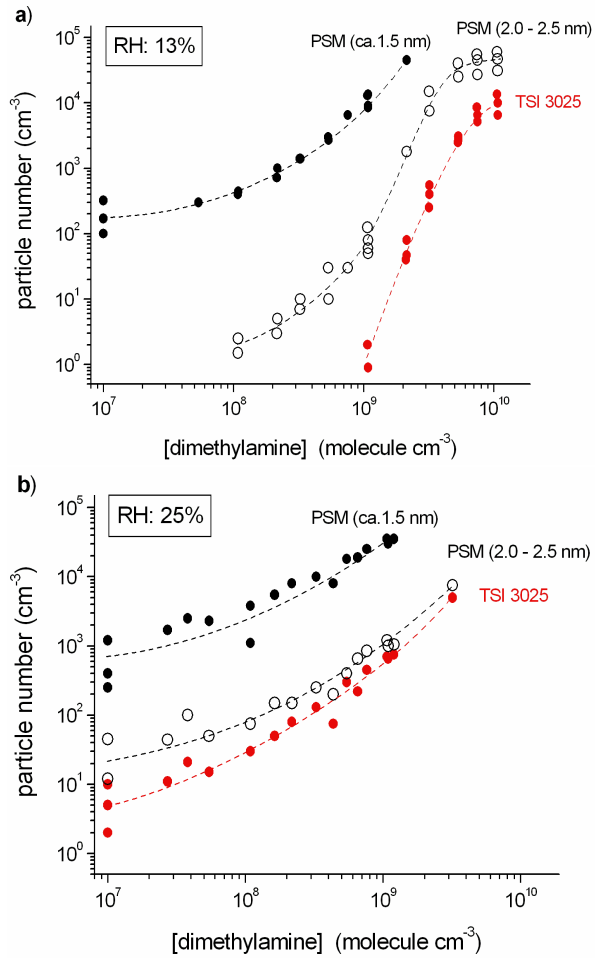
Fig. 5. Particle numbers as a functions of added dimethylamine con- centration at a relative humidity of 13% (a) and 25% (b) , [H 2 SO 4 ] = 2 × 10 8 moleculecm − 3 . Measurements have been done by PSM with a diethyleneglycol flow of 0.5 Lmin − 1 (50% cut-off size: about 1.5nm), a diethyleneglycol flow of 0.2 Lmin − 1 (50% cut-off size: about 2.0–2.5nm), and by TSI 3025 (50% cut-off size: about 2.5–3.0nm). Measurements without amine addition are given at the x axis at 10 7 moleculecm − 3 .